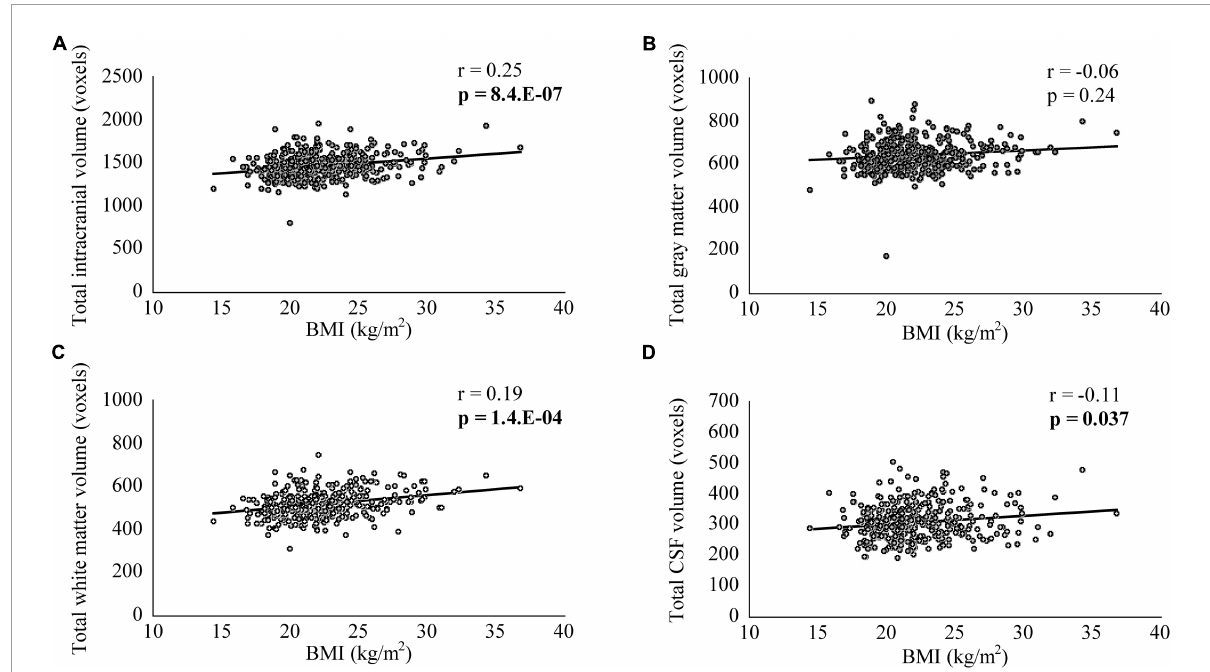
FIGURE1 The correlation between body mass index (BMI) and total intracranial, gray matter, white matter, and cerebrospinal fluid (CSF) volumes. BMI was significantly and positively correlated with total intracranial (A) and white matter volumes (C) , while it was significantly and negatively correlated with total CSF volume (D) . There was no significant correlation between BMI and total gray matter volume (B)